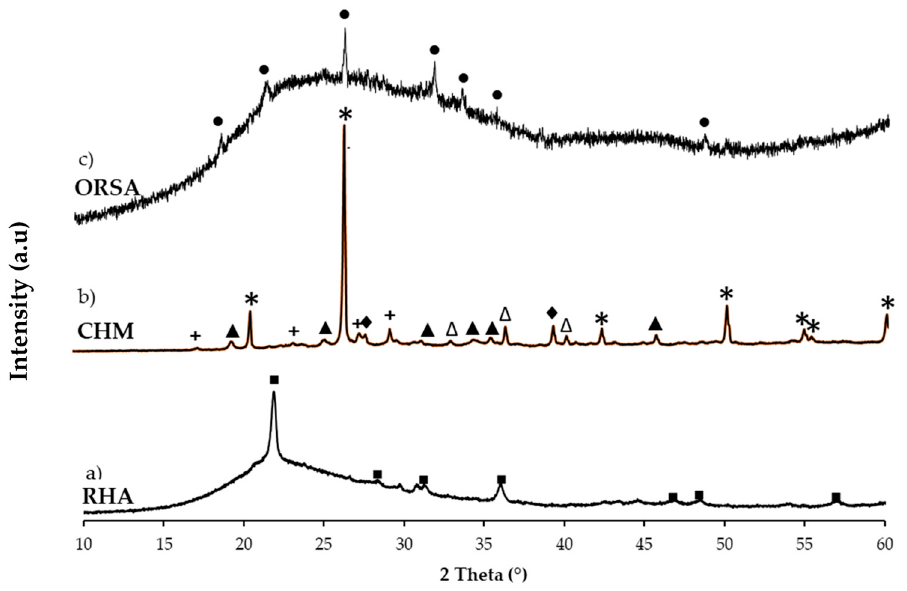
Figure 3. XRD patterns of raw materials: ( a ) Rice husk ash (RHA); ( b ) Chamotte (CHM) and ( c ) oil refining sludge ash (ORSA). (*: quartz; ∆ : hematite; +: nephelite; ▲: illite; ♦: albite; ■: cristobalite; ●: AlPO 4 ).